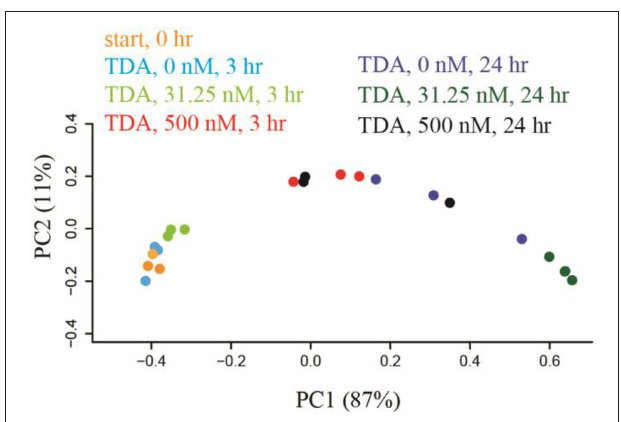
FIGURE 6 | Microbiota were shifted by TDA addition in a dose-dependent manner within 3 h treatment based on weight-Unifrac PCoA with respect to treatment time and TDA concentration. TDA (500nM)-treated microbiota shifted the microbiota structure away from 3 h-microbiota cluster toward the